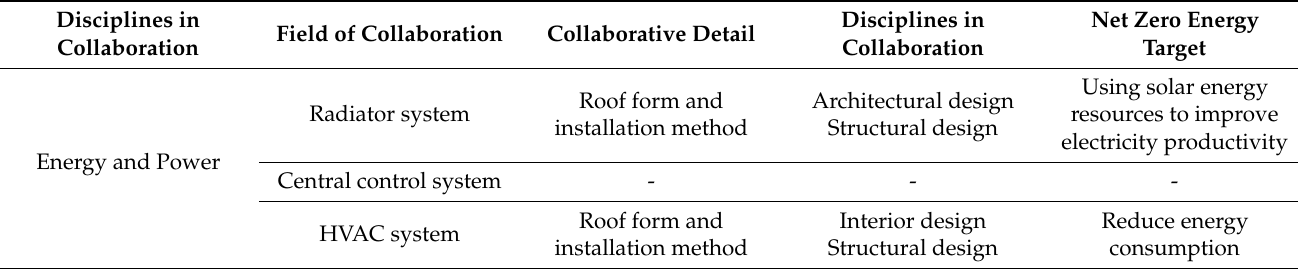
Table 5. The collaboration-oriented active design in the refining design